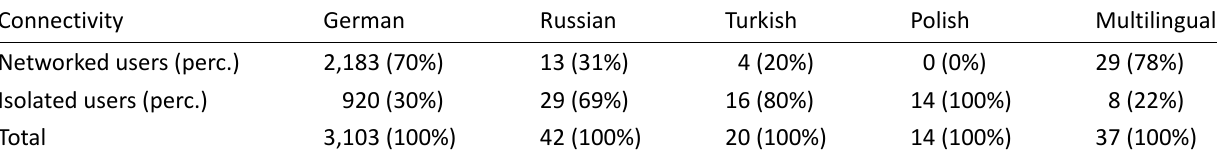
Table 2. Networked and isolated users across all language communities. Connectivity German Networked users (perc.) Isolated users (perc.)